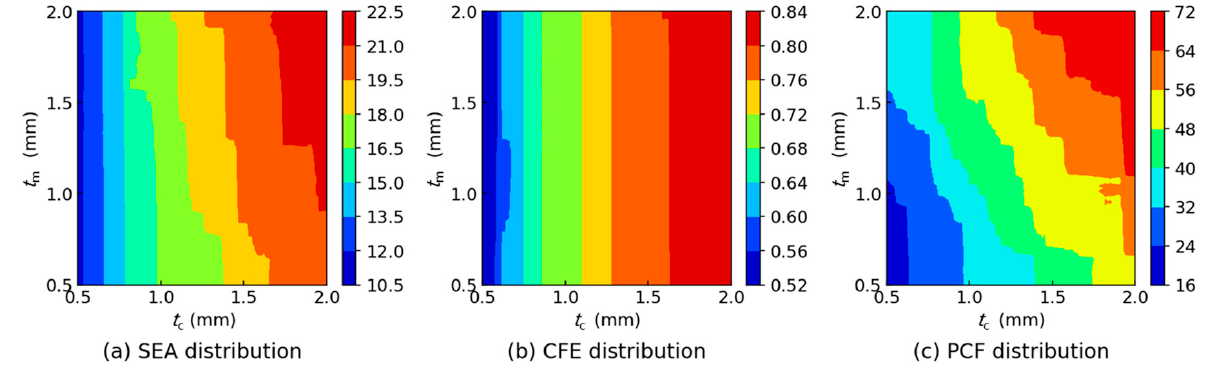
Figure 11. Energy absorption responses distribution under n = 1 for ( a ) SEA, ( b ) CFE and ( c ) PCF.